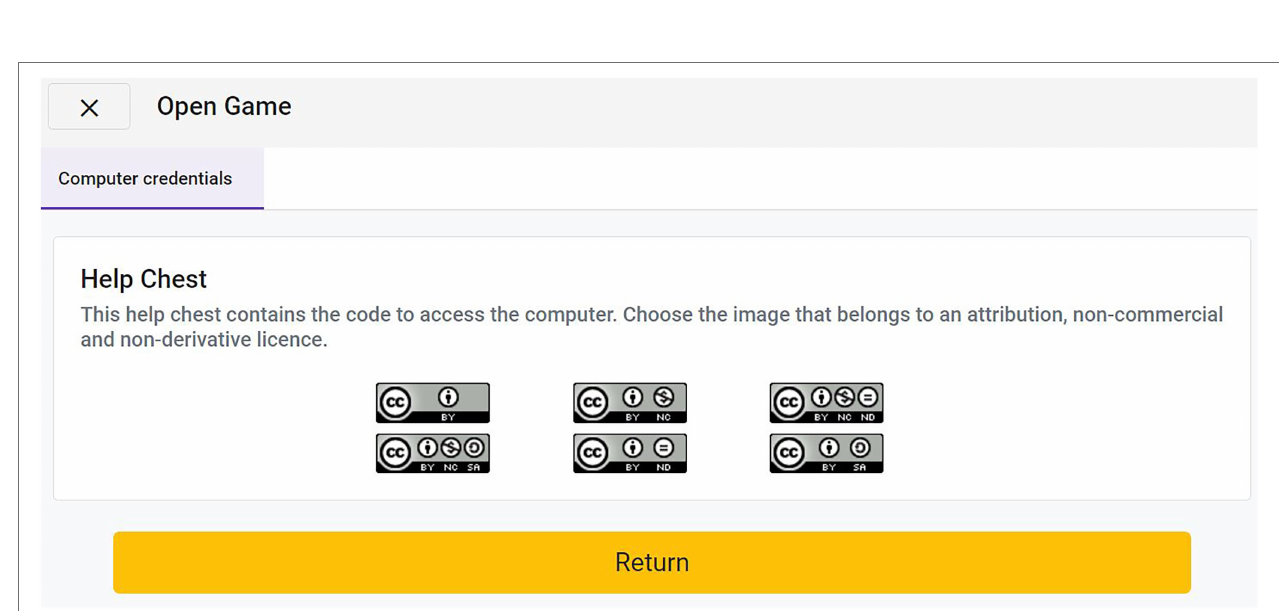
FIGURE 8 | Instructions to access level 2 of Module A in the Auditorium A.